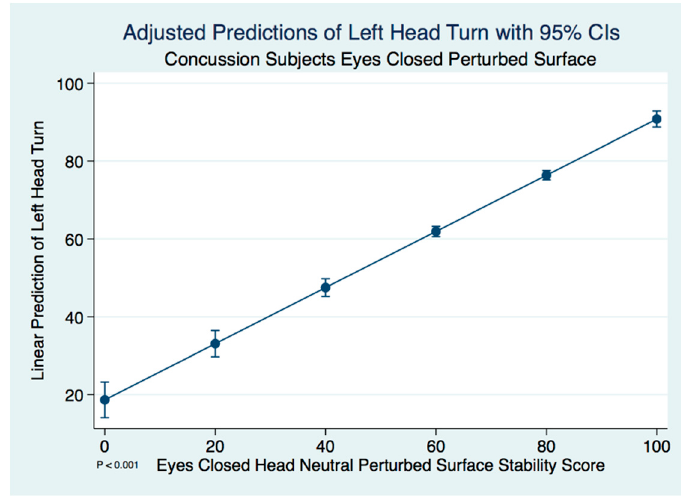
Figure 3. Adjusted predictions of left head turn stability scores in concussion subjects.